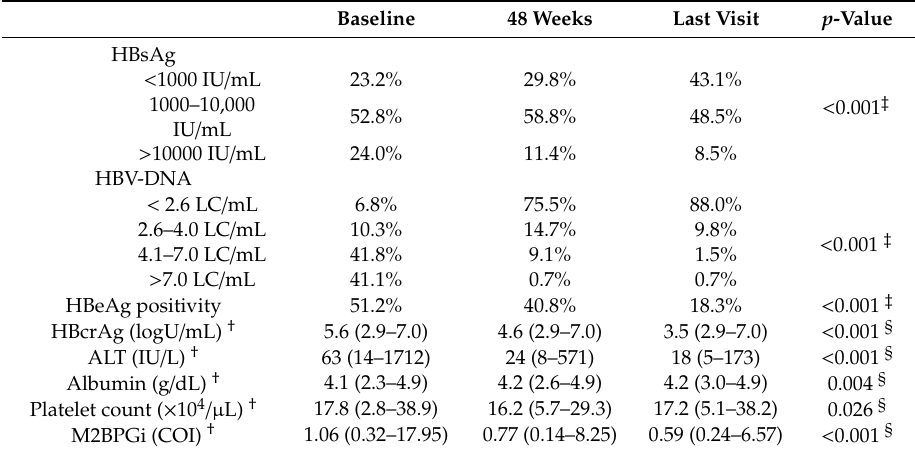
Table 1. Virologic and biochemical data during NA treatment.